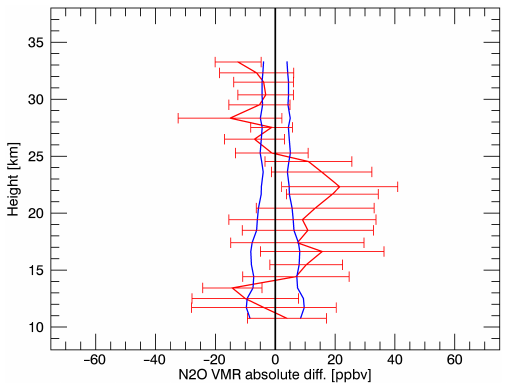
Figure 7. Same as left panel of Fig. 3, but instead of CH 4 now N 2